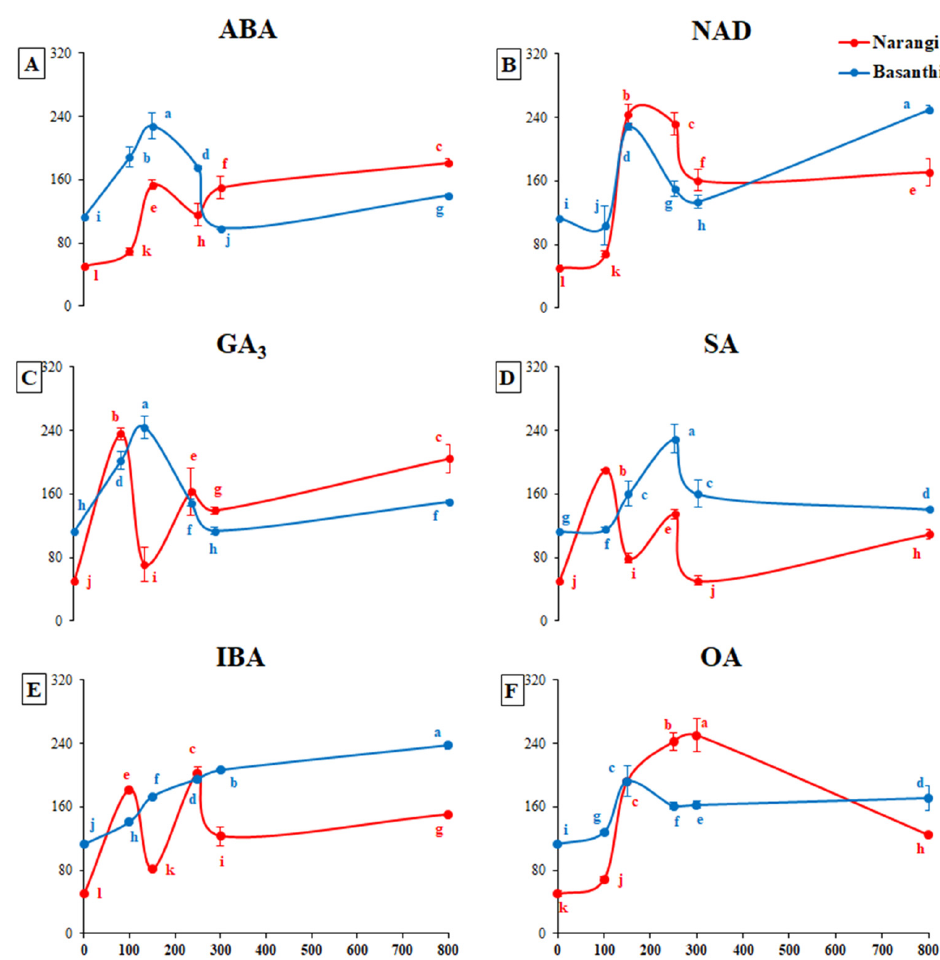
Figure 5. Total phenolic contents (mg ∙ g − 1 ) of two cultivars of marigold (“Pusa Narangi Gainda” and “Pusa Basanthi Gainda”) as affected by different doses (mg ∙ L − 1 ) of ABA ( A ); NAD ( B ); GA 3 ( C ); SA ( D ); IBA ( E ) and OA ( F ). Same letters indicate non ‐ significant difference among treatments under Fisher’s least significant difference test ( p ≤ 0.05 ). Vertical bars indicate average ± standard error (three replications, under bi ‐ factorial CRD).